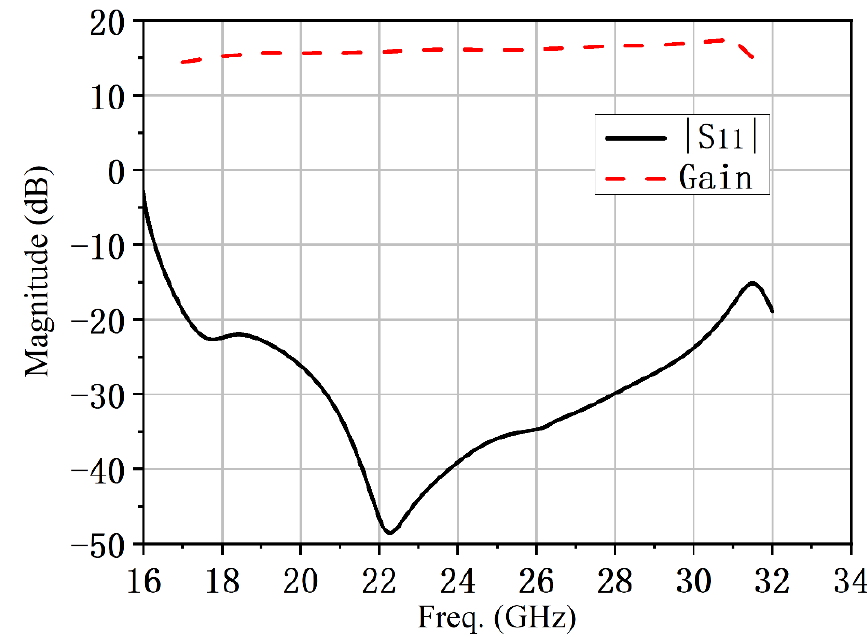
Figure 13. Simulated results of the proposed conical corrugated horn antenna.